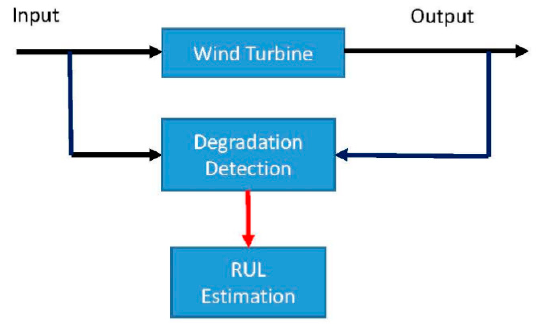
Figure 7. Schematic diagram of fault prognosis.